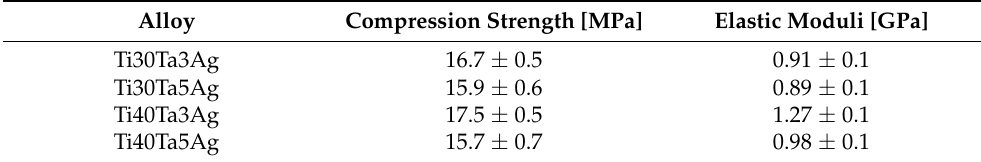
Table 5. The mechanical properties of Ti-Ta-Ag foams.